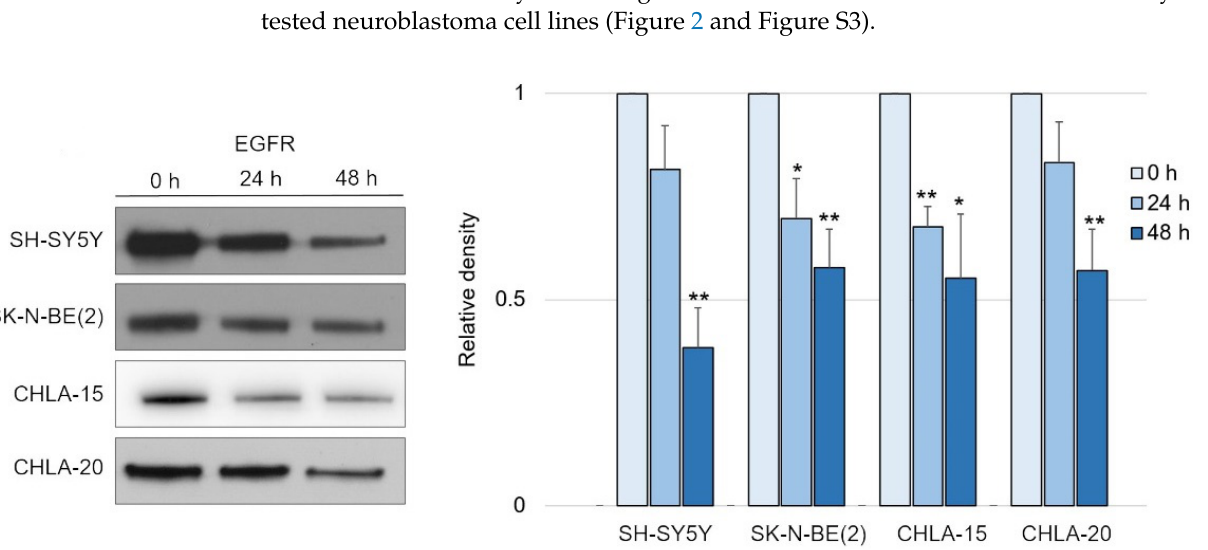
Figure 2. EGFR is downregulated in response to iron-chelation therapy by DpC. Immunoblotting of EGFR protein levels in neuroblastoma cell lines treated with 20 µ M (SH-SY5Y, SK-N-BE(2)) or 2 µ M (CHLA-15, CHLA-20) DpC. Representative images ( left ) and relative optical density values ( right ) of three independent experiments. Source data are provided in Figure S1. Densitometry data are shown as the mean ± SD normalized to 0 h values. * p < 0.05; ** p < 0.01, two-tailed unpaired t - test.